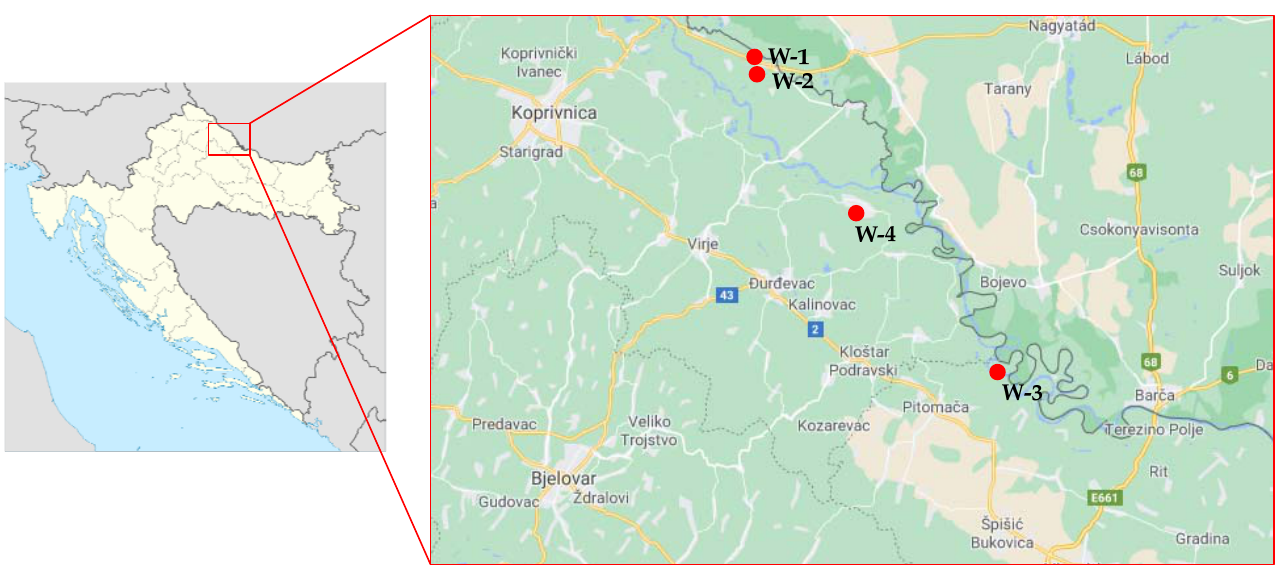
Figure 4. Locations of the wells in the northern part of Croatia. Table 14. Geological and well design data for the selected wells. W ‐ 1–W ‐ 4: well 1–well 4.